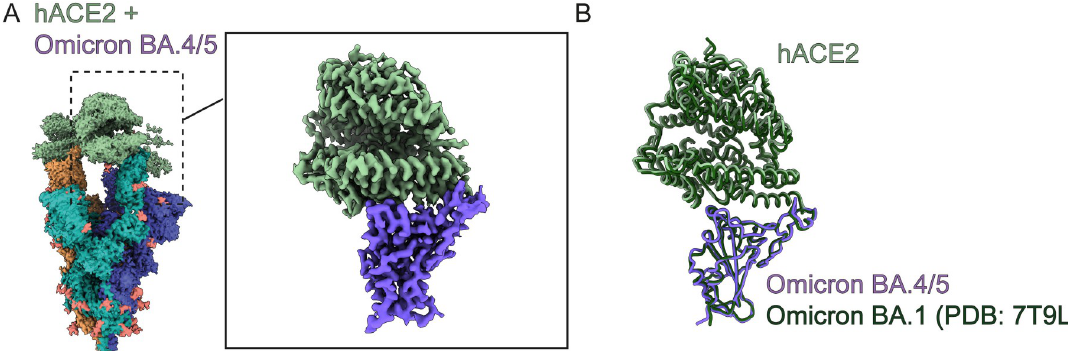
Fig 3. Cryo-EM structures of hACE2 bound to the BA.4/5 Spike. (A) Cryo-EM densities of the full hACE2/BA.4/5 Spike. Each protomer of the Spike trimer is colored separately with hACE2 colored in light green. Inset shows focused refinement of the RBD- hACE2 interface. (B) Superposition of BA.4/5 RBD-hACE2 complex with the BA.1 RBD-hACE2 complex (PDB 7T9L).